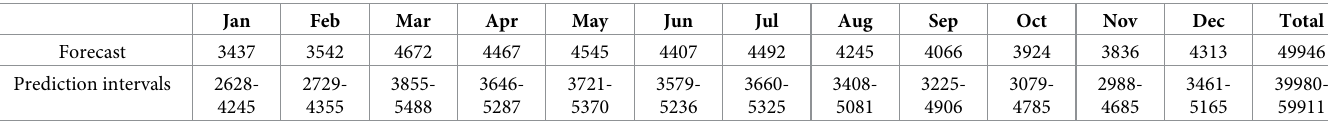
Table 2. Forecasted values for tuberculosis notification in